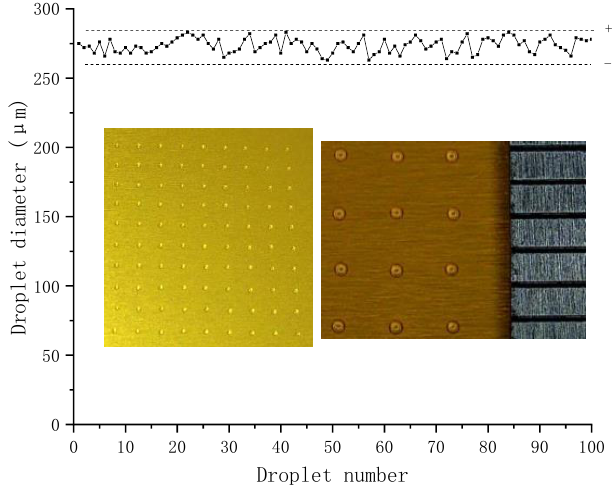
Figure 18. Droplet diameter distribution.